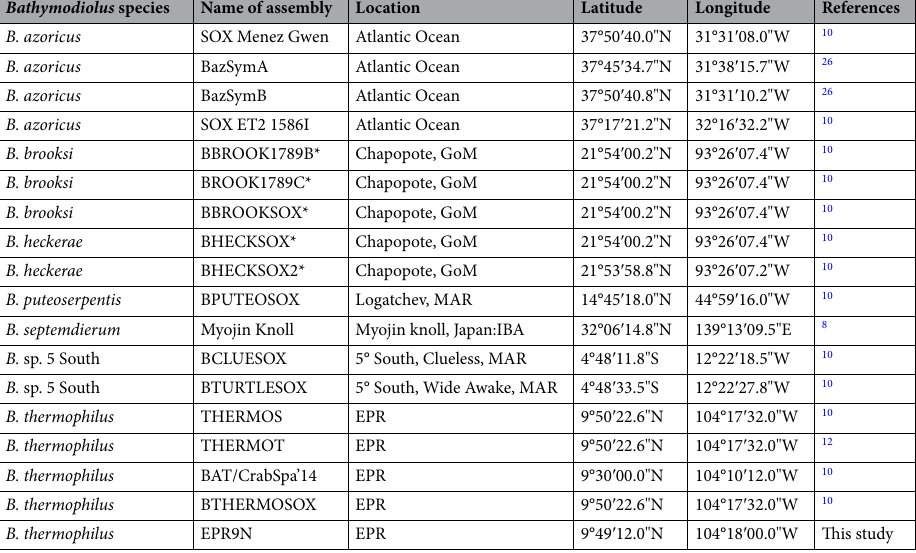
Table 1. General information about Bathymodiolus thiotrophic symbiont genomes used for phylogenomic analyses. GoM Gulf of Mexico, EPR East Pacific Rise, MAR Mid Atlantic Ridge, IBA Izu-Bonin Arc. *From the cold seep habitat. Remaining assemblies are from the hydrothermal vent